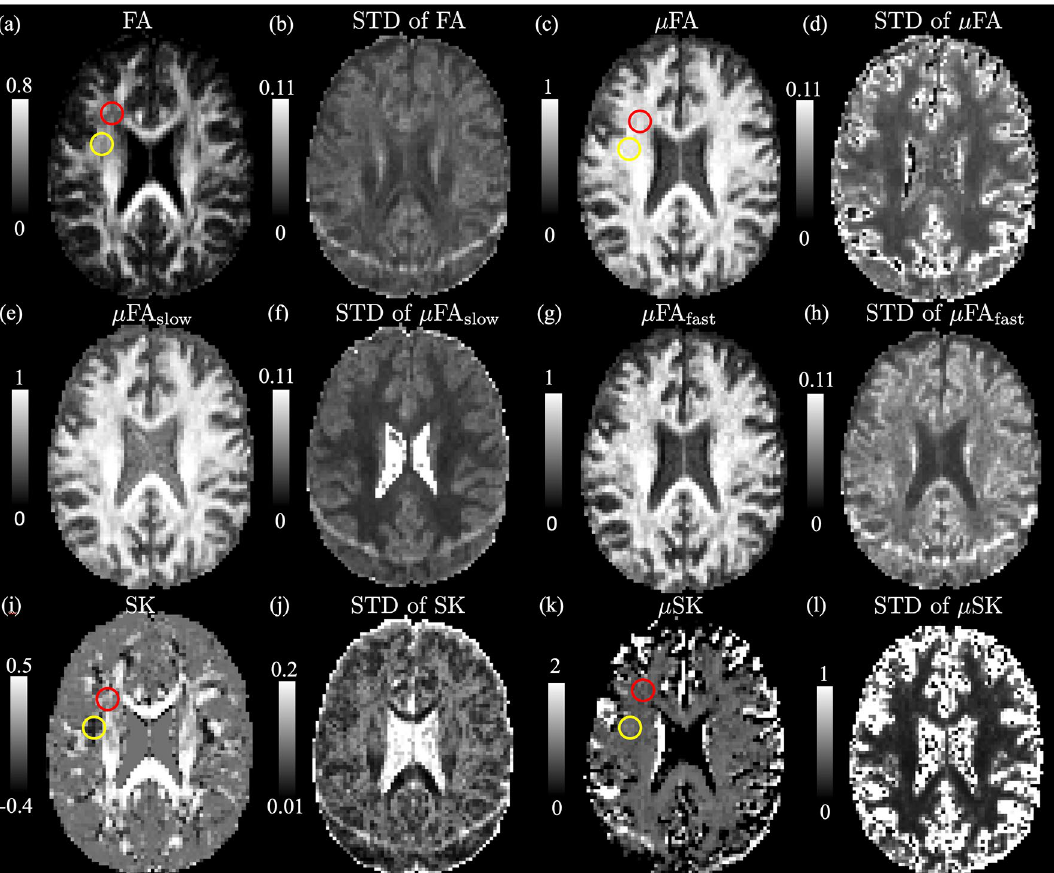
Figure 3. Illustration of dMRI indices and the corresponding uncertainty of an axial slice of dMRI volume from a human brain. The first row shows the FA , µ FA and the corresponding standard deviation (STD). The second row illustrates the µ FA slow and µ FA fast measures, where µ FA slow has relative higher values than µ FA fast . The third row shows SK and µ SK . SK has negative values in the white-matter region highlighted by the red and yellow circle whereas the corresponding µ SK are positive, indicating that the underlying microscopic diffusion tensors have prolate shapes that are related to crossing fibers or fiber dispersion. Parameter uncertainty is inflated in a band toward the posterior of the brain. This is likely due to poor fat saturation causing a mixture of fat and water signals at this location, as previously described by 9